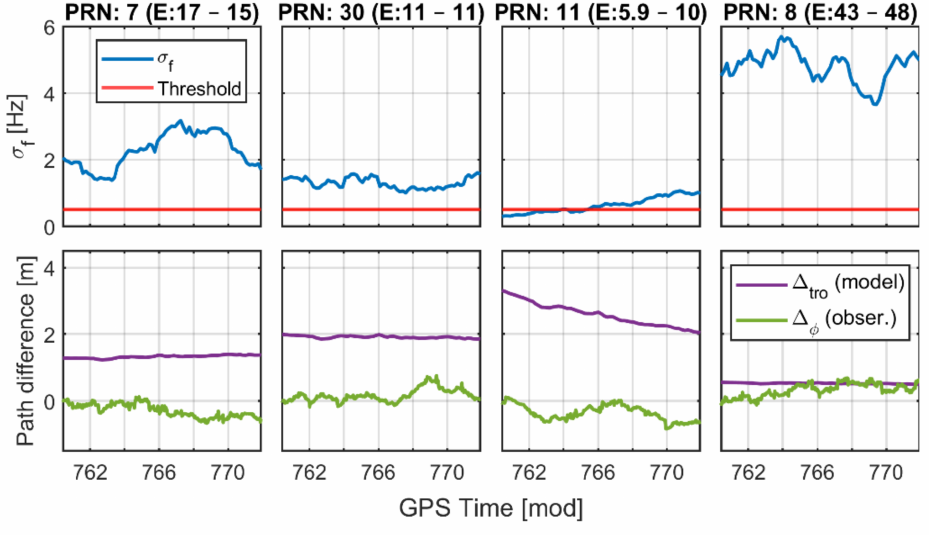
Figure 12. Doppler spread and tropospheric residual model compared with observed path difference from the residual phase on 15 July 2019. The satellite PRN number and the elevation angle range are indicated in the title of each